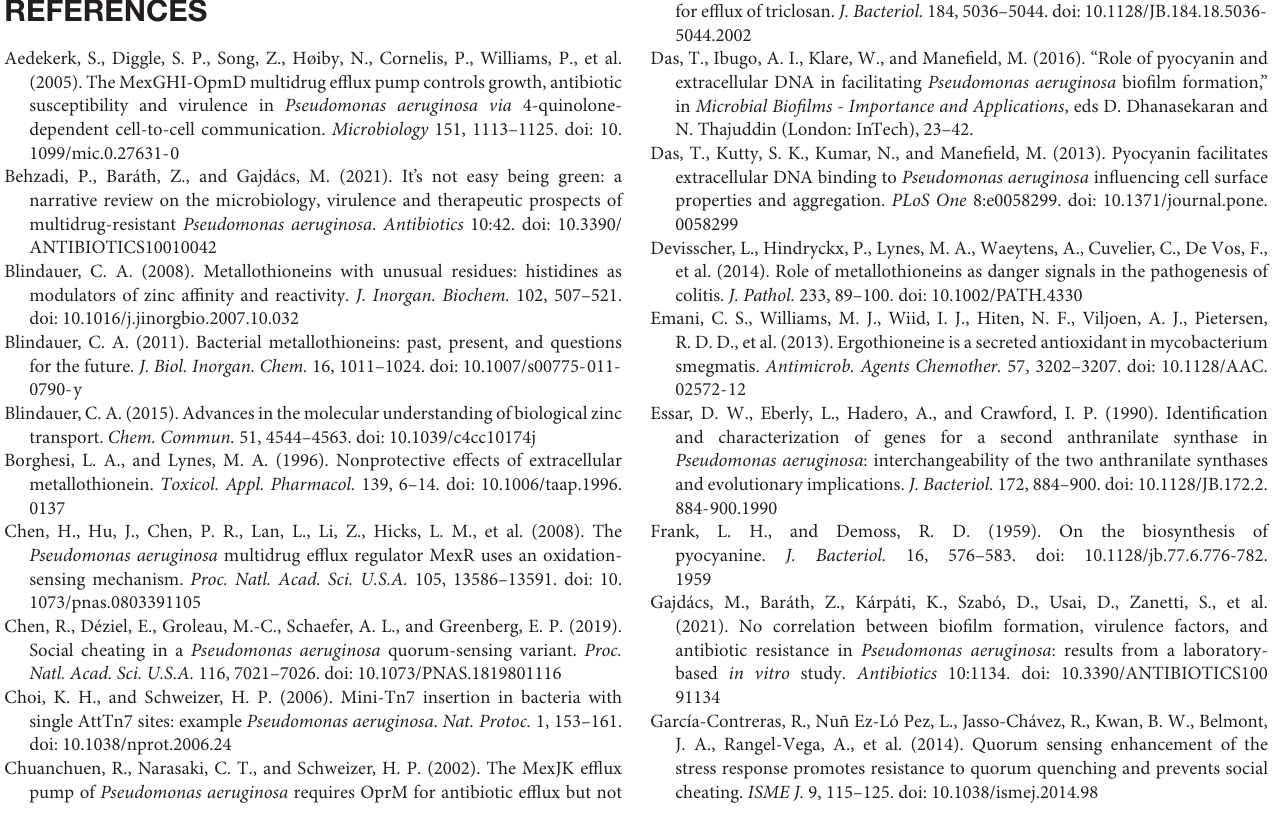
Supplementary Figure S1 | Schematic representation of P. aeruginosa pmtA knock-out strain construction. Schematic indicates the generation of the (cid:49) pmtA mutant. Supplementary Figure S2 | Confirmation of Tn7 insertion into clean deletion mutant by colony PCR. Lanes 2, 3, and 4 used the pTn7GM_F and pTnGM_R primers, while lanes 5 and 6 used the PPA2140_Tn7_F and PA2140_Tn7_R primers with GoTaq Green Master Mix as previously described. Lane 1, 100 bp ladder; lane 2, pUC18R6K-mini-Tn7T-Gm-promoterPA2140 transformant (979 bp); lane 3, complemented (cid:49) pmtA mutant ( (cid:49) pmtA:pmtA ); lane 4, pUC18R6K-mini-Tn7T-Gm empty vector (261 bp); lane 5, wild-type PAO1 (781 bp); and lane 6, complemented (cid:49) pmtA mutant (cid:49) pmtA:pmtA (781 bp). Supplementary Figure S3 | P. aeruginosa strains PAO1, (cid:49) pmtA, and (cid:49) pmtA:pmtA grow at similar rates. Single colonies of the P. aeruginosa strains